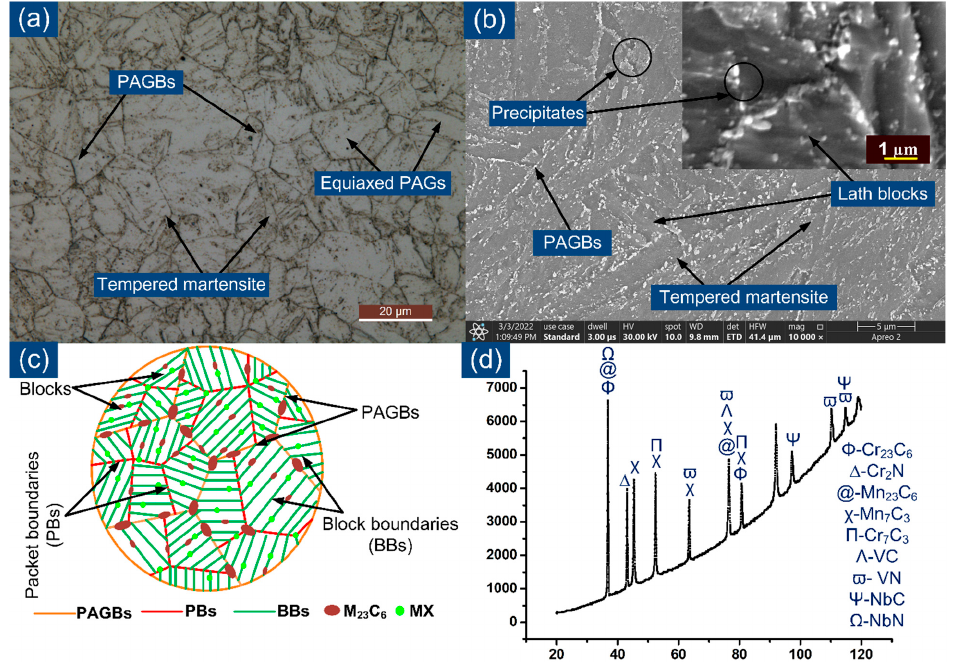
Figure 3. ( a ) Optical image showing tempered martensitic microstructure and boundaries, ( b ) SEM image showing lath blocks, boundaries and precipitate decoration along boundaries and inside the matrix, ( c ) schematic showing precipitate decoration along boundaries and blocks, and ( d ) XRD profile showing the phases present in P92 steel.